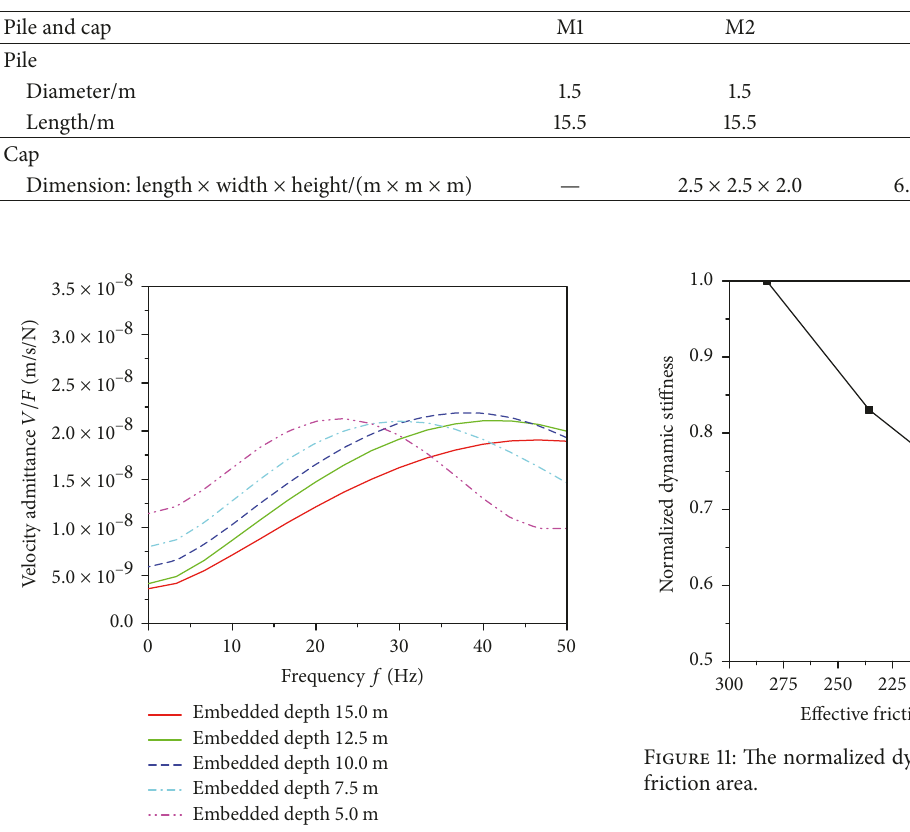
Figure 9: The time history and velocity admittance of the cap response.